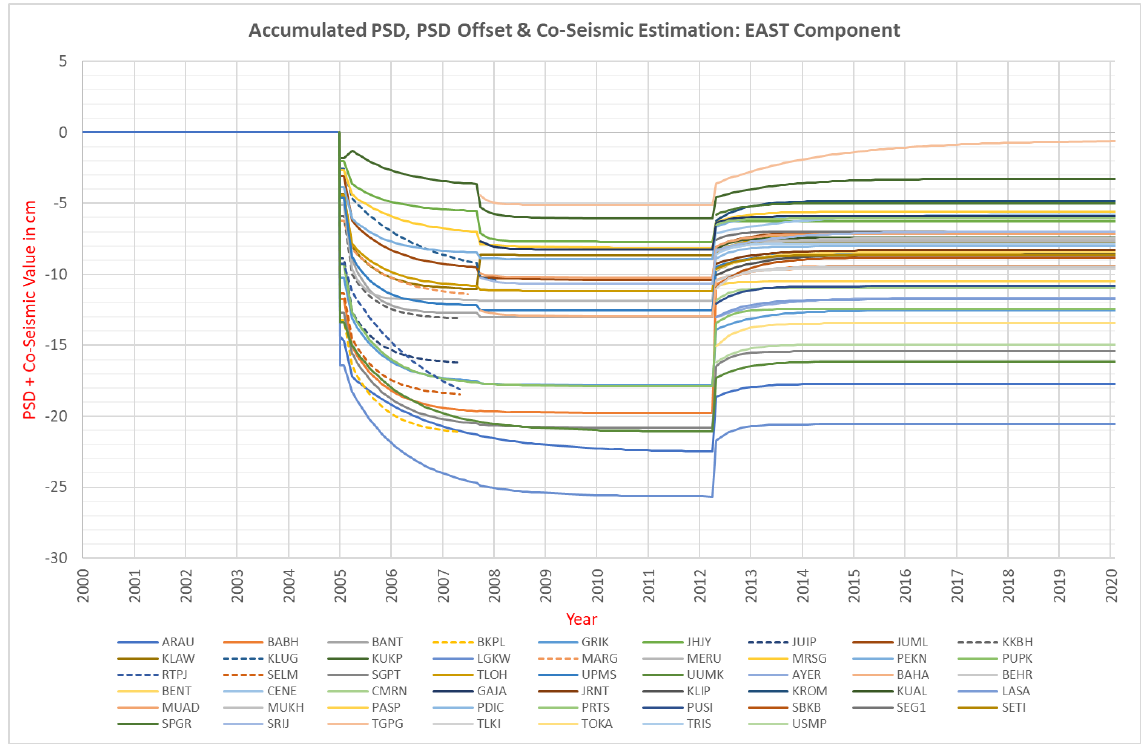
Fig. 13. Filtered co-seismic+ PSD parametric model trajectories (computed at 30-day intervals) of the Malaysian CORS stations in the E-W direction from epoch 2000.0 to 2020. Dashed lines indicate decommissioned CORS